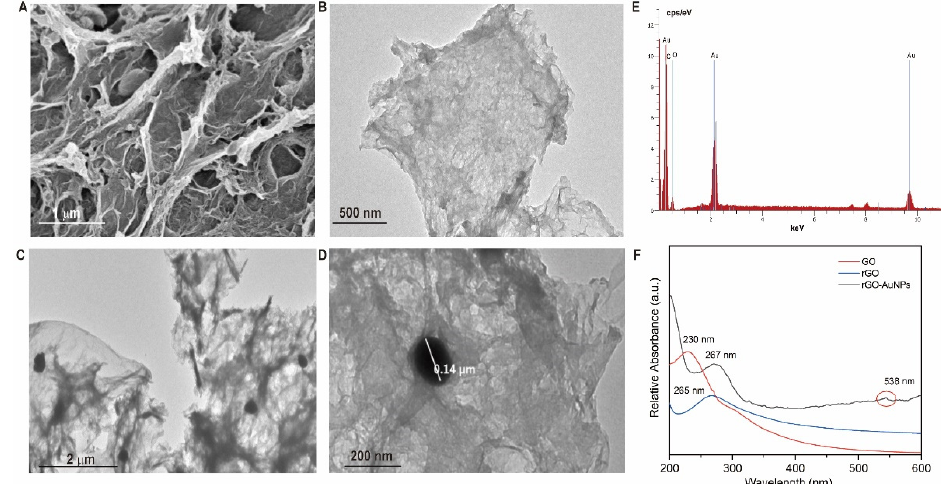
Figure 3. ( A , B ) Scanning electron microscopy (SEM) images of the prepared of 3D-rGO/AuNPs at different magnifications; ( C , D ) transmission electron microscopy (TEM) images of reduced graphene oxide (RGO) and rGO-AuNPs; ( E ) energy-dispersive X-ray spectroscopy (EDS) of 3D- rGO/AuNPs; and ( F ) UV-vis spectra of graphene oxide (GO), reduced graphene oxide (rGO) and rGO-AuNPs nanocomposites.